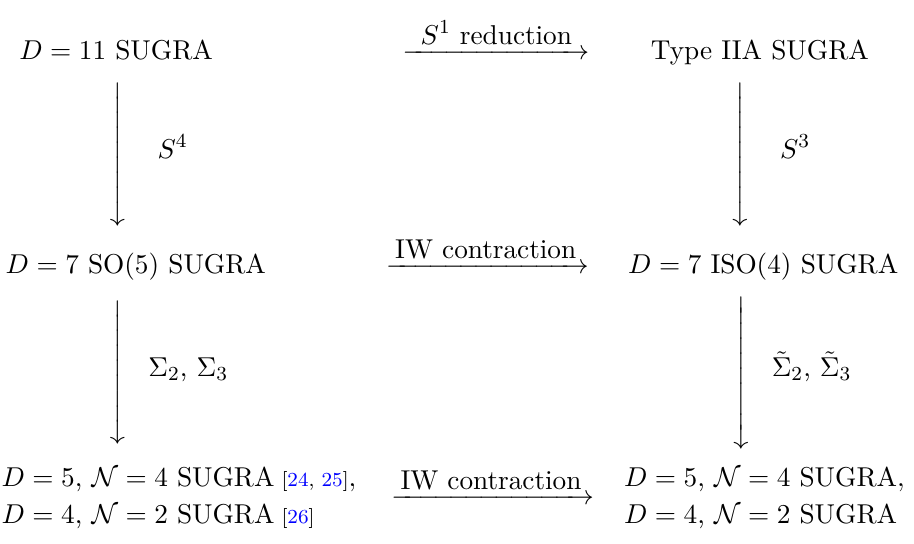
Figure 1 . The possible routes of truncation. The IW contraction can be performed at any of the specified points, but it is computationally easiest at the 4/5-dimensional